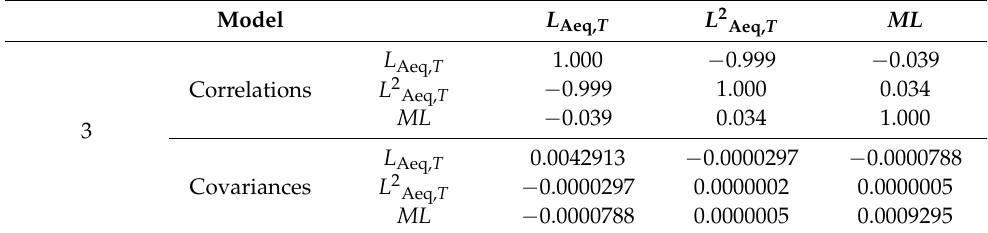
Table 10. Correlations and covariances of the variables in the selected